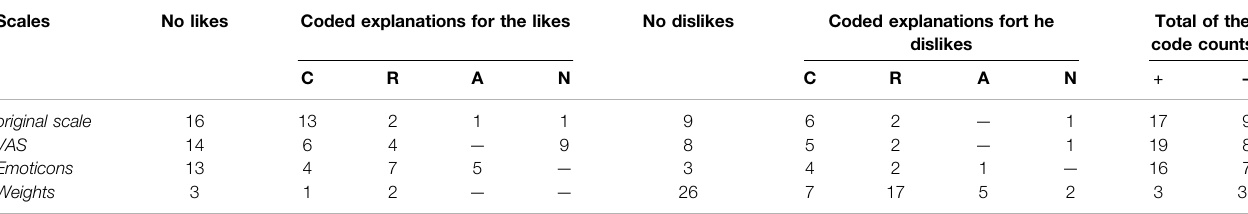
TABLE 2 | Overview of Participants ’ best and least Preference and Coded Explanations for the Four Types of Rating Scales. Scales No likes Coded explanations for the